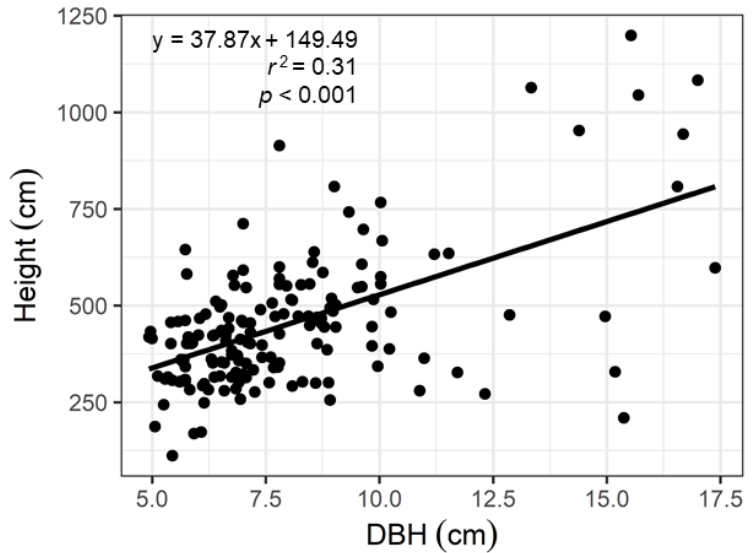
Figure 3. The relationship between diameter at breast height (DBH) and understory tree height. Solid line shows the results of the linear model.